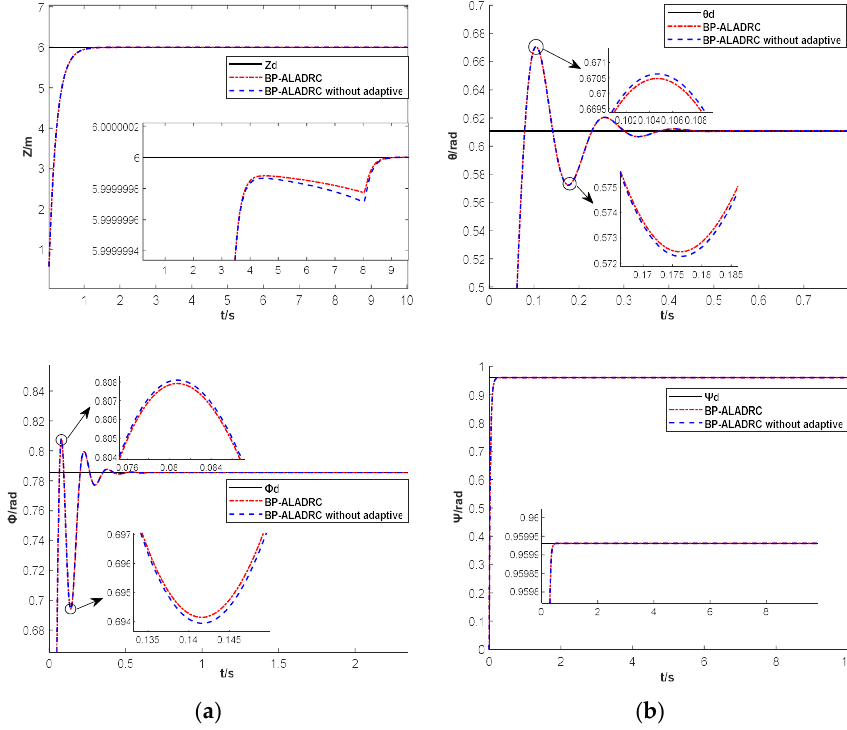
Figure 11. System output: (a) Altitude and Roll angle output; (b) Pitch and Yaw angle output.